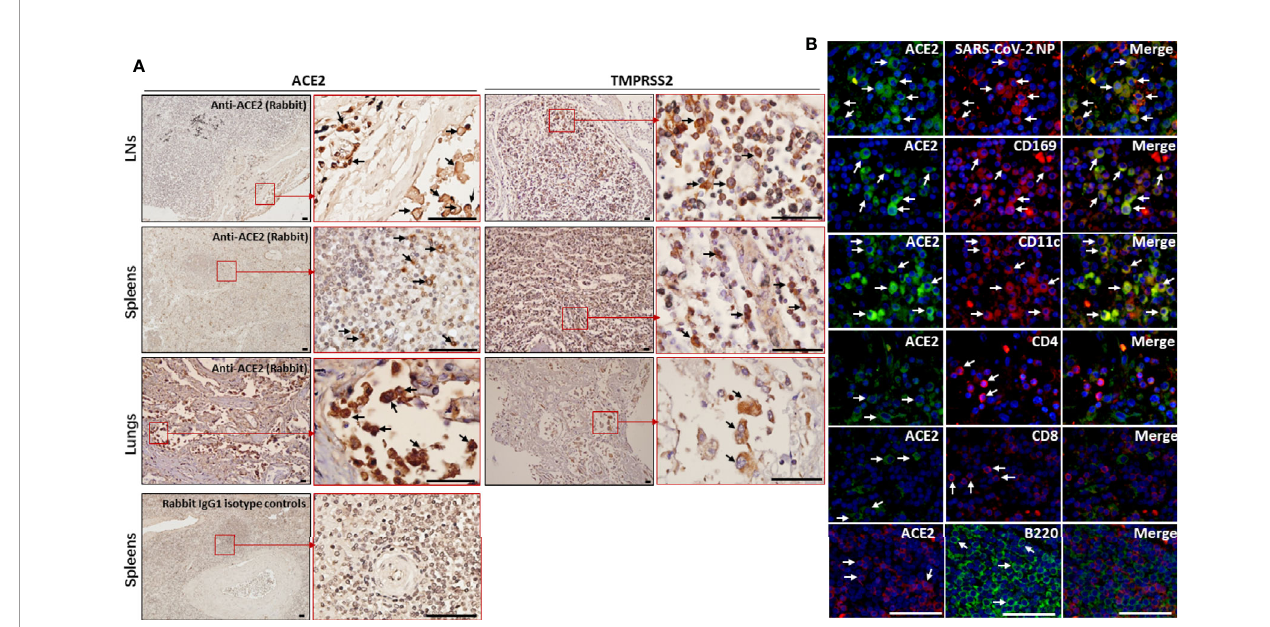
FIGURE 3 | The expression of ACE2 and TMPRSS2 was observed by macrophages and DCs in spleens and hilar LNs. The spleen, hilar LNs and lung tissues from one representative COVID-19 post-mortem case (case #2) were collected, (A) the expression of ACE2 and TMPRSS2 was detected by IHC, arrows indicate positive cells; (B) immuno fl uorescent double staining analysis of ACE2 antigen on indicated cells within hilar LNs, scale bar= 50 m M, arrows indicated double positive cells and arrow heads showed single positive